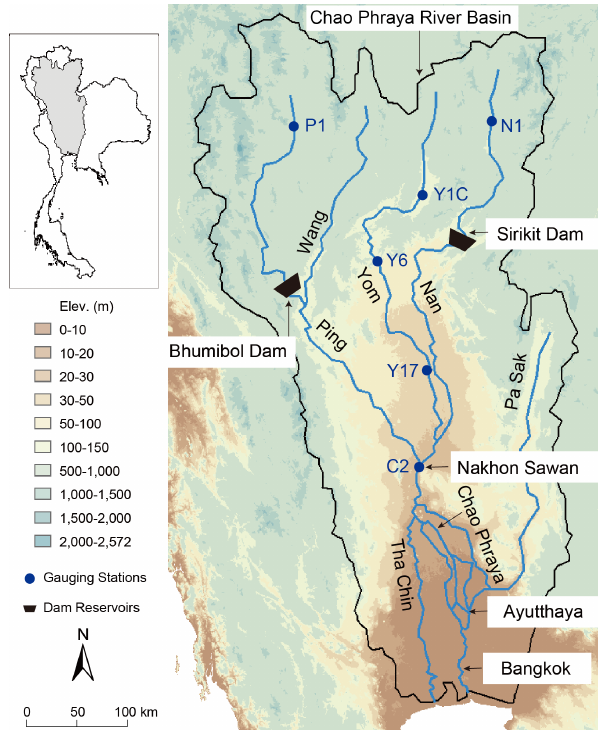
Figure 1. Map of the Chao Phraya River basin, Thailand.